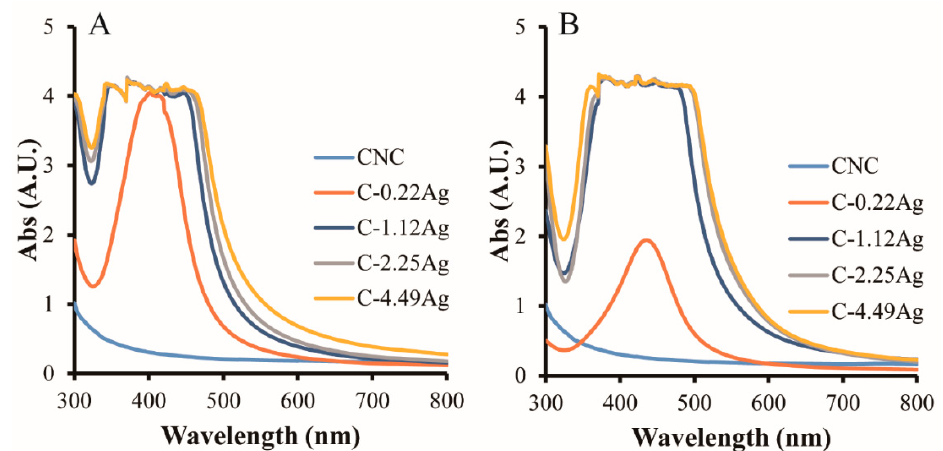
Figure 2. UV-Vis spectra of neat CNC and CNC-AgNP composites; liquids ( A ) and composite films ( B ).